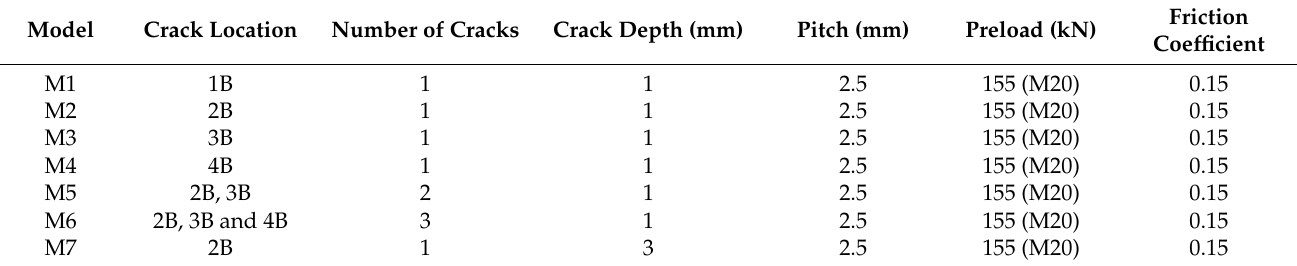
Table 1. Working Condition of Crack